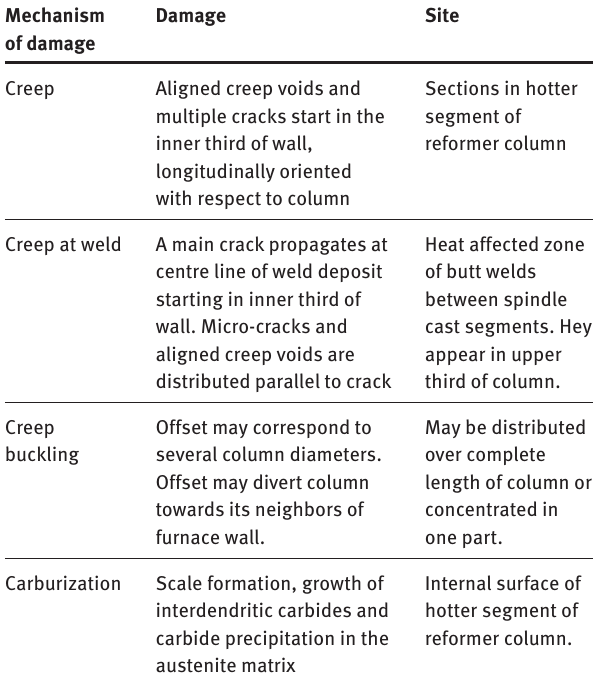
Table 4: Mechanisms for life Extinction of reformer columns [11].